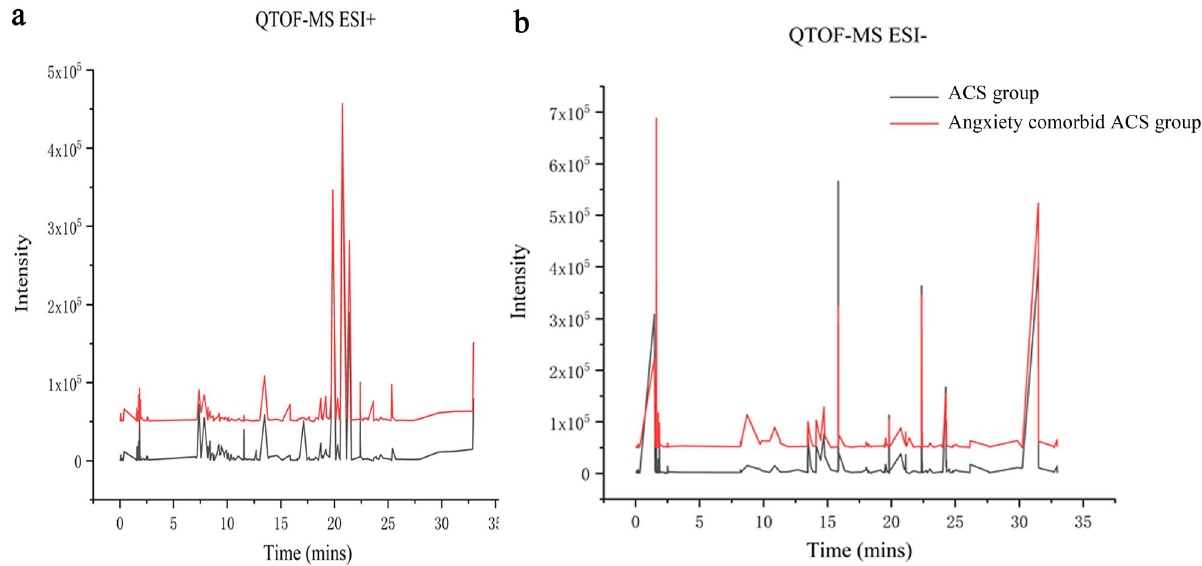
Figure 3. Representative LC–MS analysis of total ion chromatograms for plasma. Plasma samples in positive ( a ) and negative mode ( b